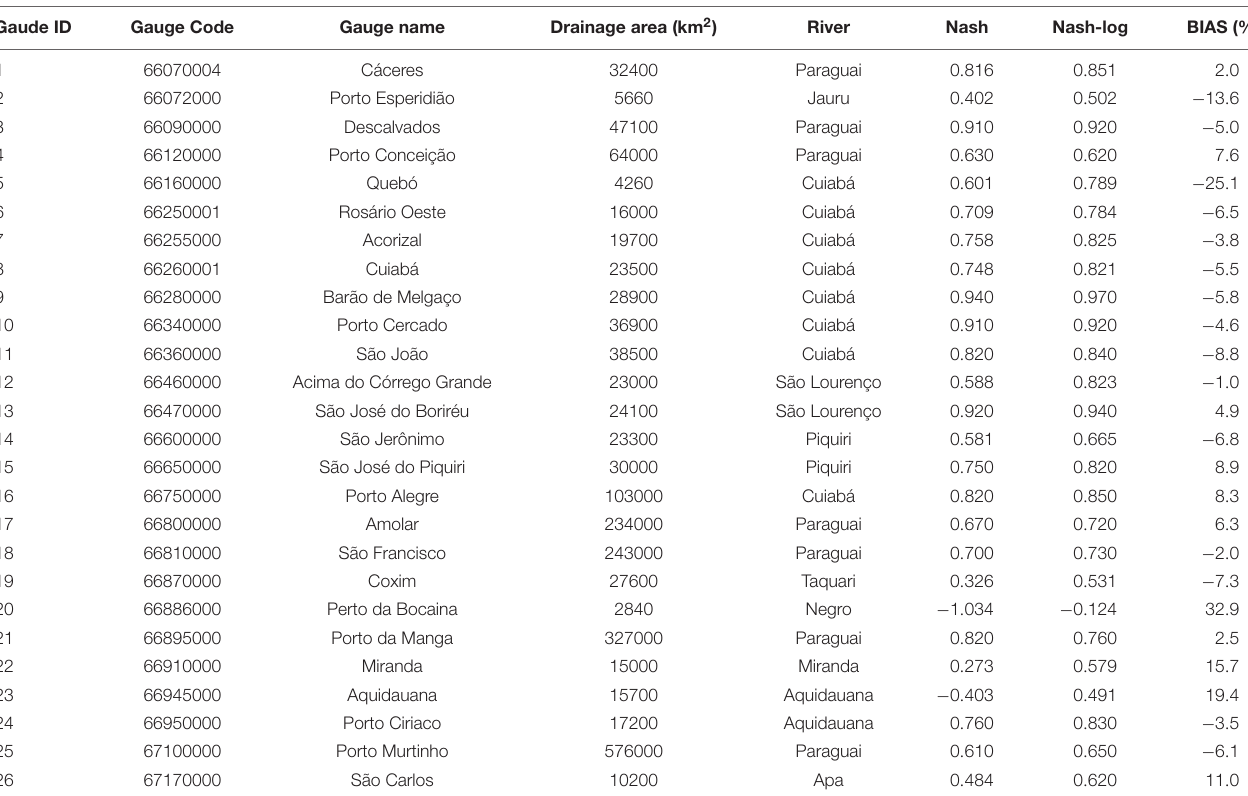
TABLE 1 | Characteristics of the main river gauges presented in Figure 2 , used during calibration of the MGB and SIRIPLAN models, and the performance measures obtained. Gaude